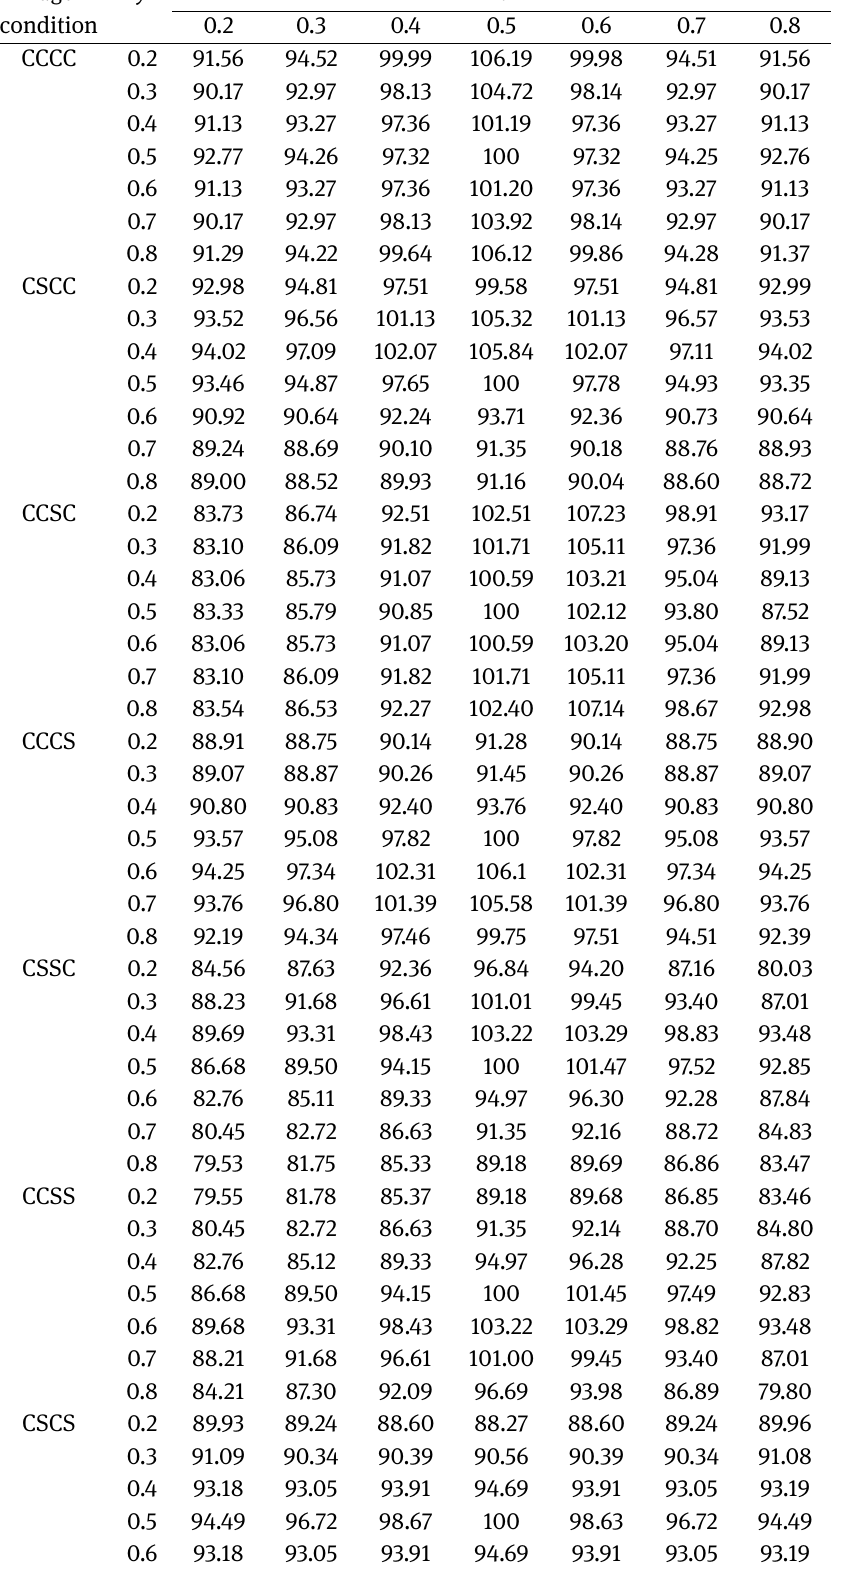
Table 7: Values of ‘ r ’ for 0/90/0/90 elliptic parabolic